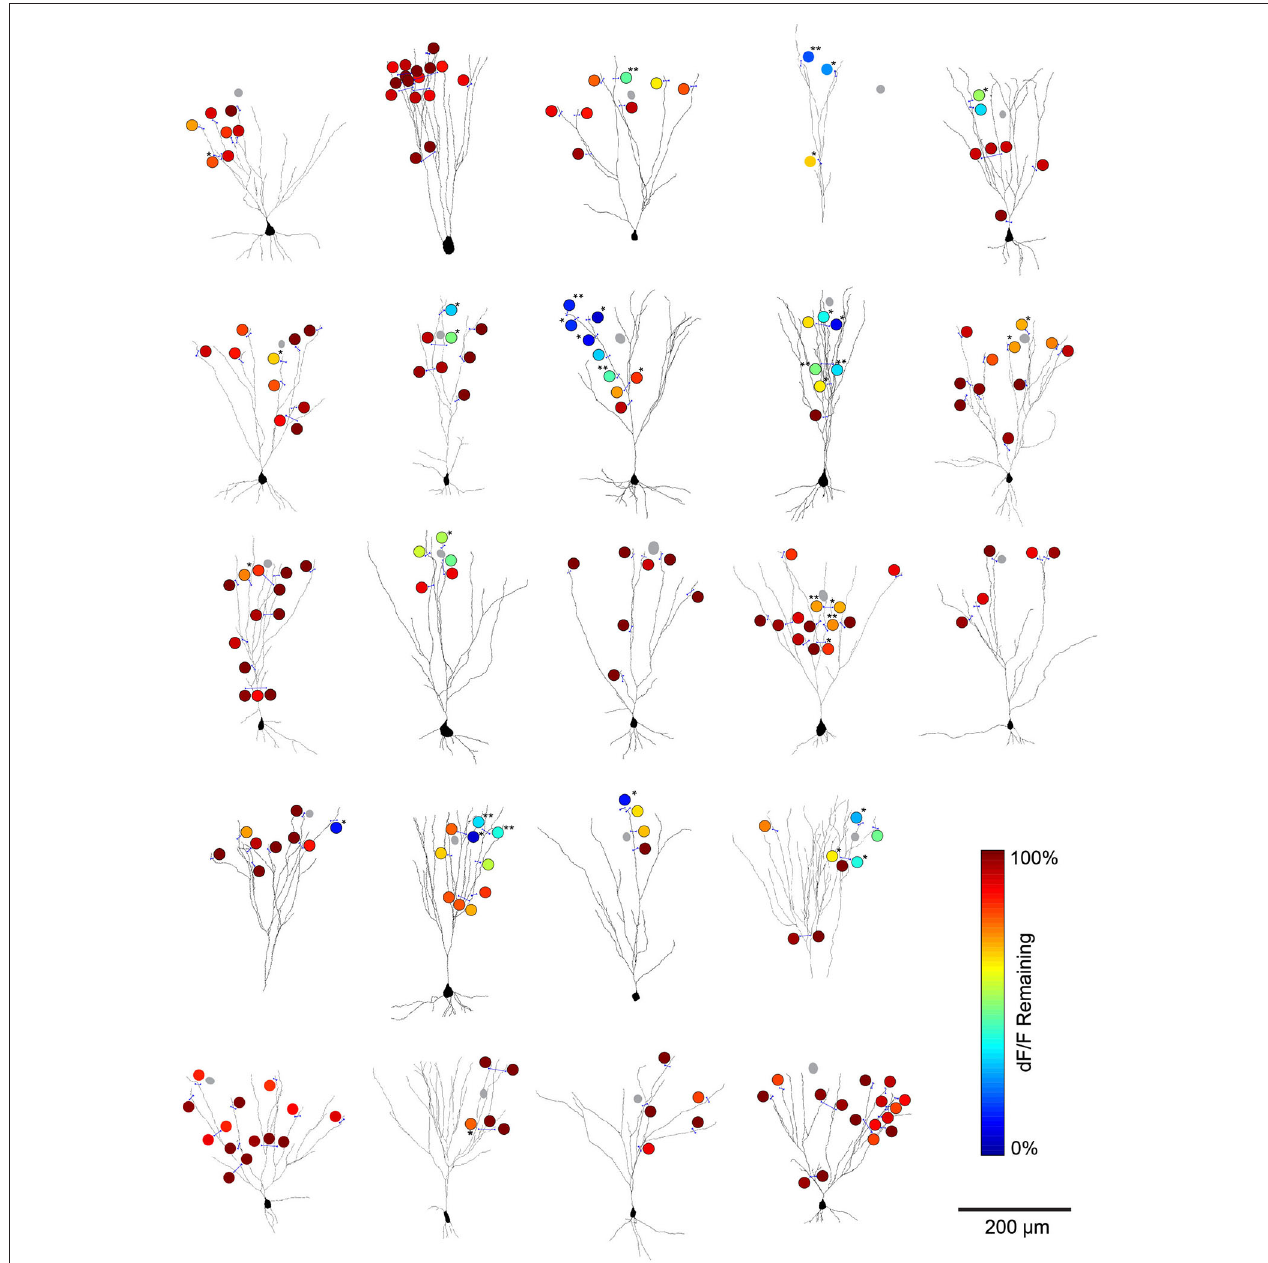
indicates the percent of the peak deltaF/F remaining when the L1 interneuron was co-activated with the L3 PC (compared to the Ca 2 + response when bAPs were evoked in L3 PCs alone). Significance calculated by student’s t -test comparing peak deltaF/F values for trials of PYR APs alone vs. trials